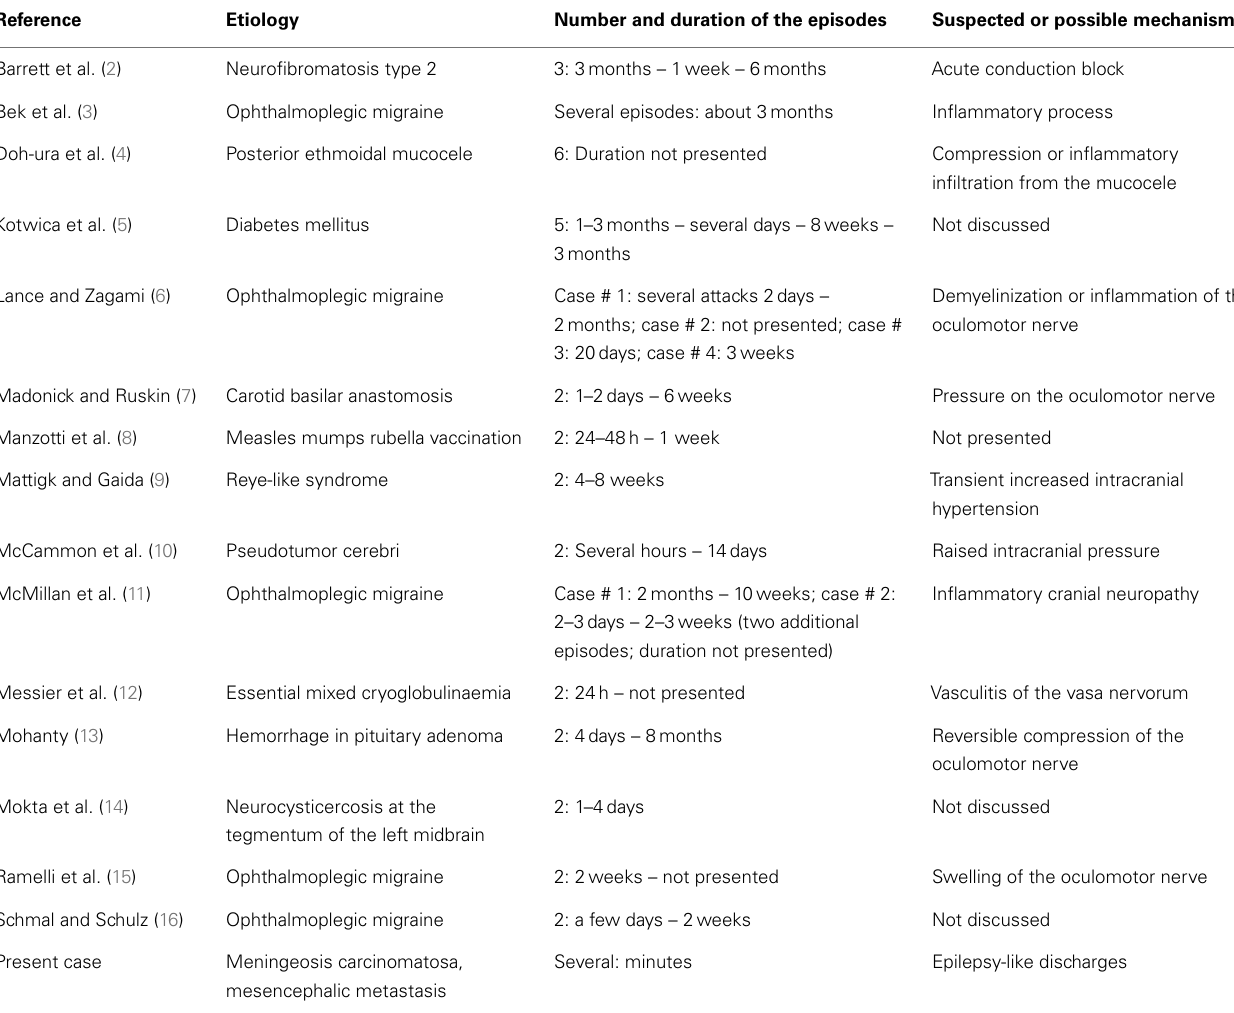
Table 1 | Spontaneously recovering recurrent oculomotor nerve palsies